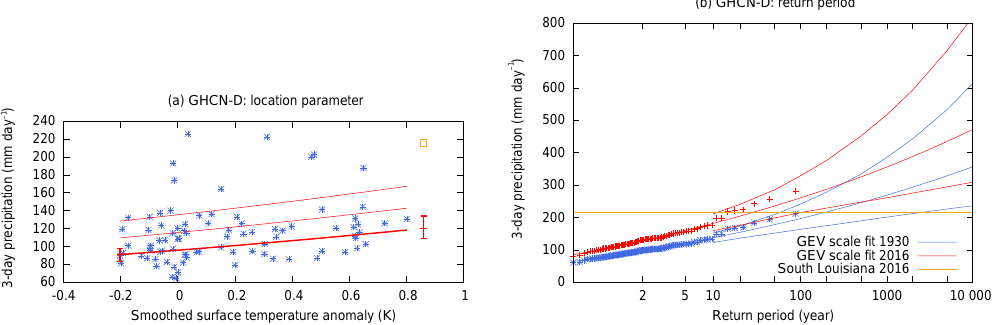
Figure 4. Fit of the spatial and annual maximum 3-day average GHCN-D station precipitation on the central US Gulf Coast to a GEV that scales with smoothed global mean surface temperature. (a) Observations (blue marks), location parameter µ (thick red line), µ + σ and µ + 2 σ (thin red lines versus global mean temperature anomalies); the two vertical red lines show µ and its 95% confidence interval for the two climates in (b) . (b) Gumbel plot of the GEV fit in 2016 (red line, with 95% uncertainty estimates) and 1930 (blue line); marks show data points drawn twice: scaled up with the trend to 2016 and scaled down to 1900. The yellow square (line) denotes the intensity of the observed event at Livingston,